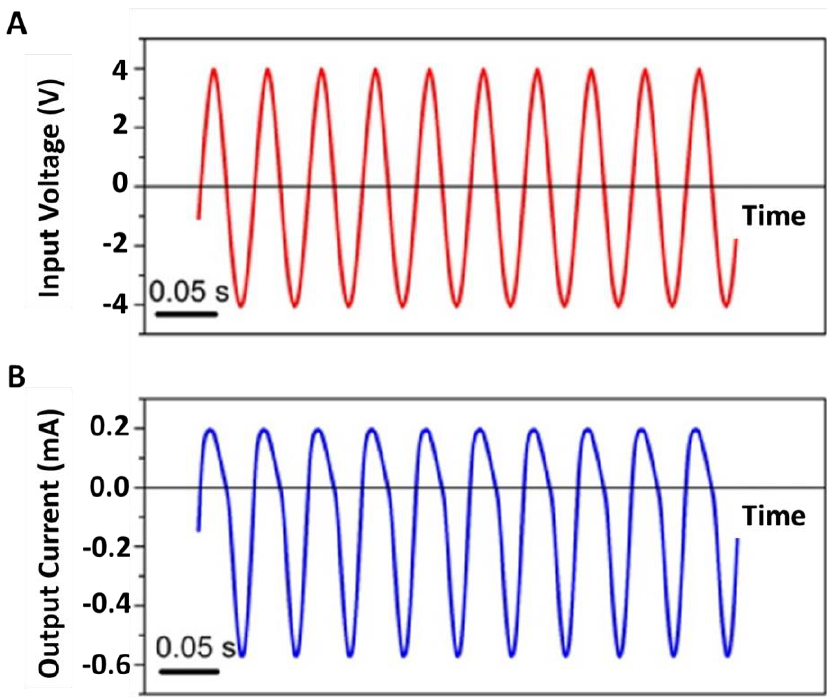
Figure 6. ( A ) Applied sinusoidal voltage waveform with magnitude of 2.8 V rms and frequency of